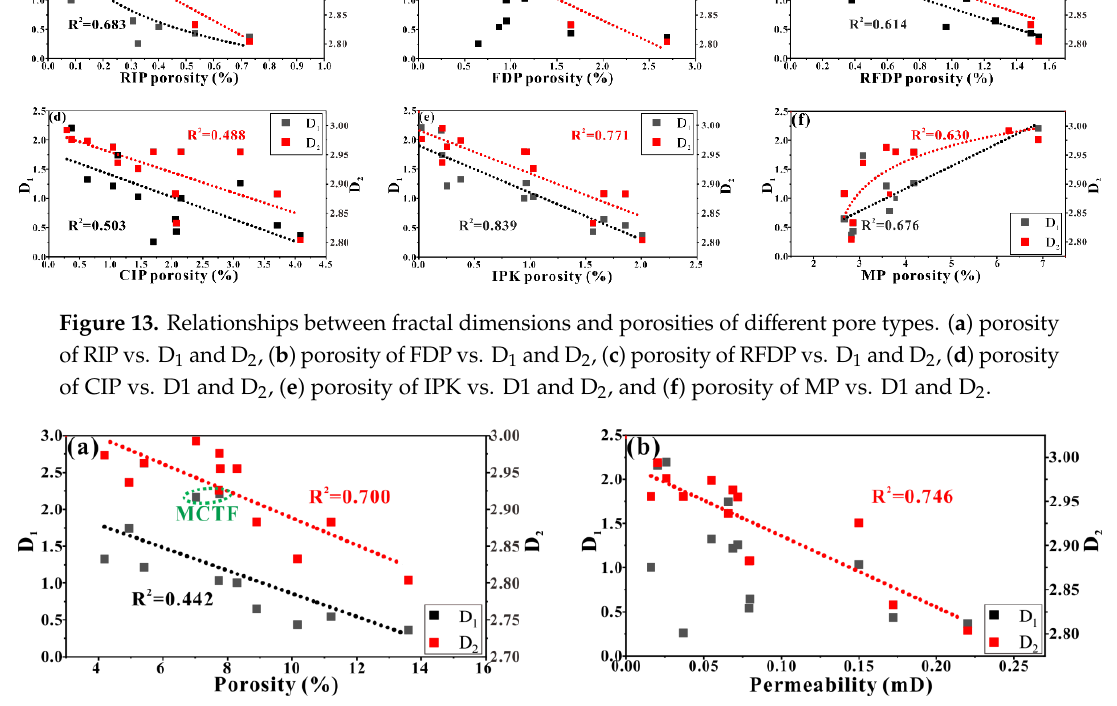
Figure 14. Relationships between the fractal dimensions and petrophysical properties. ( a ) Total porosity vs. D 1 and D 2 ; ( b ) total permeability vs. D 1 and D 2 porosity vs. D 1 and D 2 ; ( b ) total permeability vs. D 1 and D 2 .